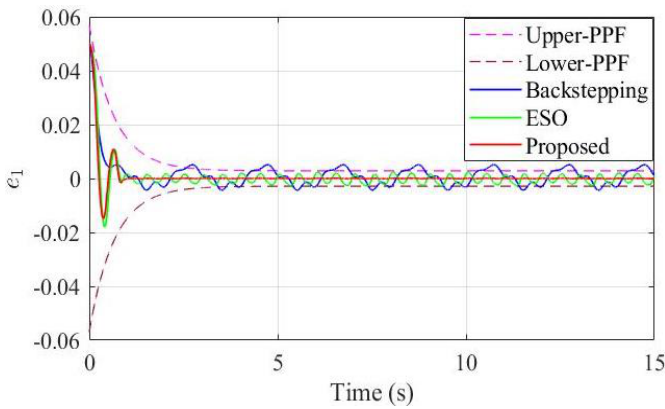
Figure 4. Tracking error of sprung mass displacement.